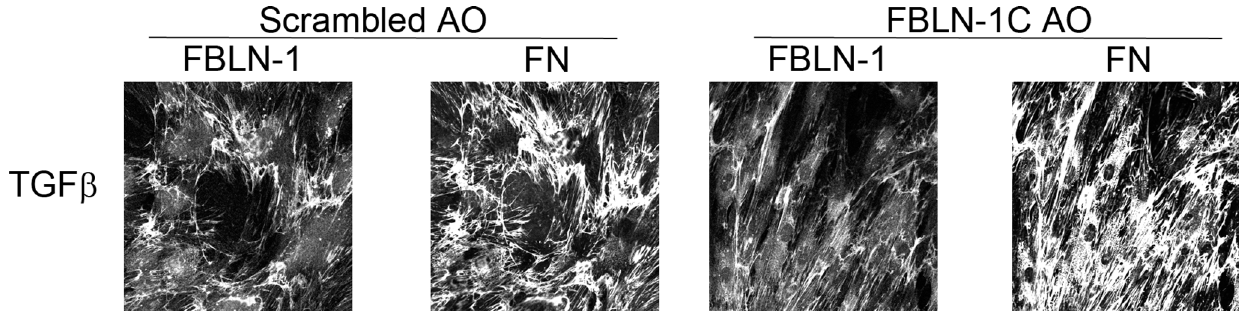
Figure 8. FBLN-1C AO inhibits FBLN-1 but not FN deposition by asthmatic ASM cells. ASM cells grown on glass coverslips in the presence of either a FBLN-1 specific AO or a scrambled AO were stimulated with TGF b and FBLN-1 and FN were detected using antibodies labeled with different fluorochromes. Images are representative of results from 4 ASM cell lines.